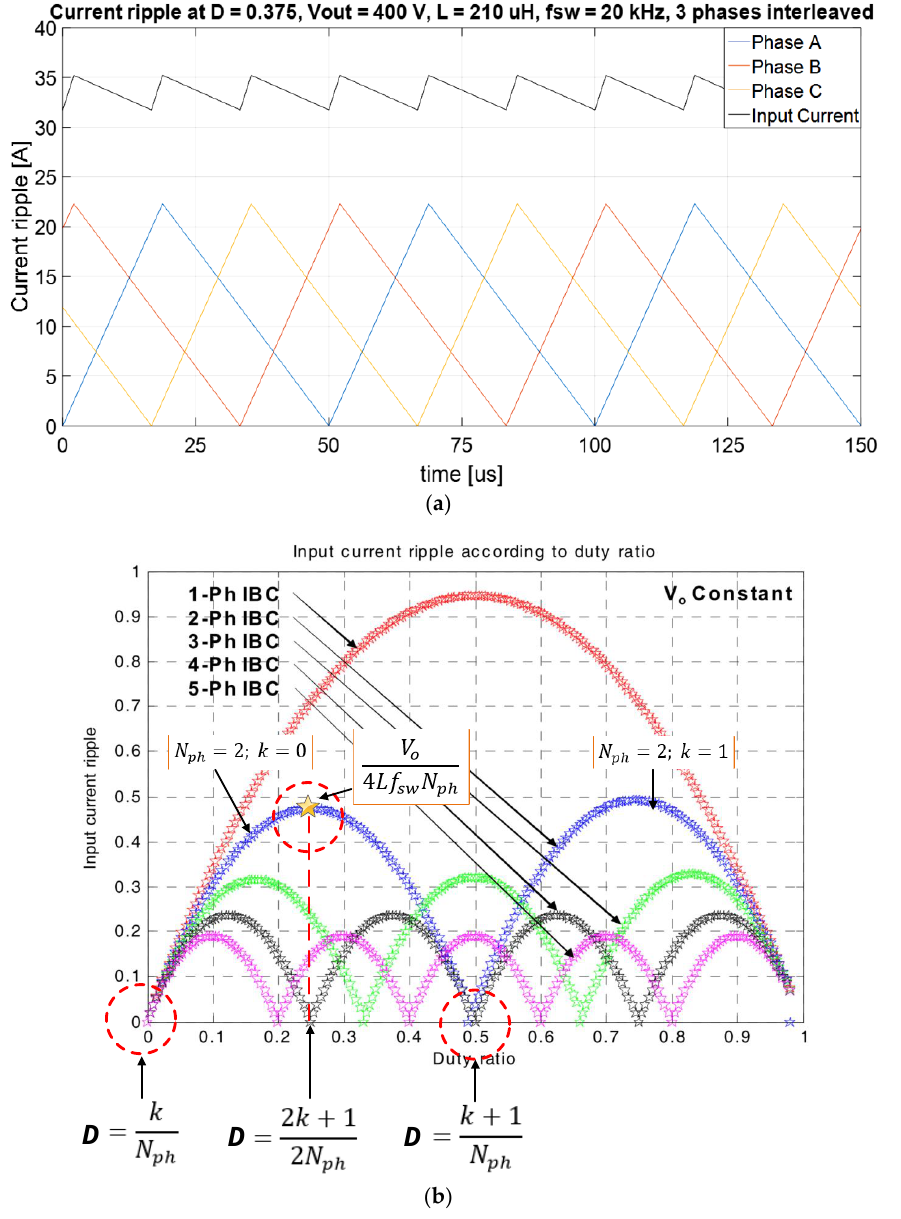
Figure 4. ( a ) Reduction of input current ripple through phase interleaving. ( b ) Normalized peak-to-peak input current ripple as a function of the duty ratio.